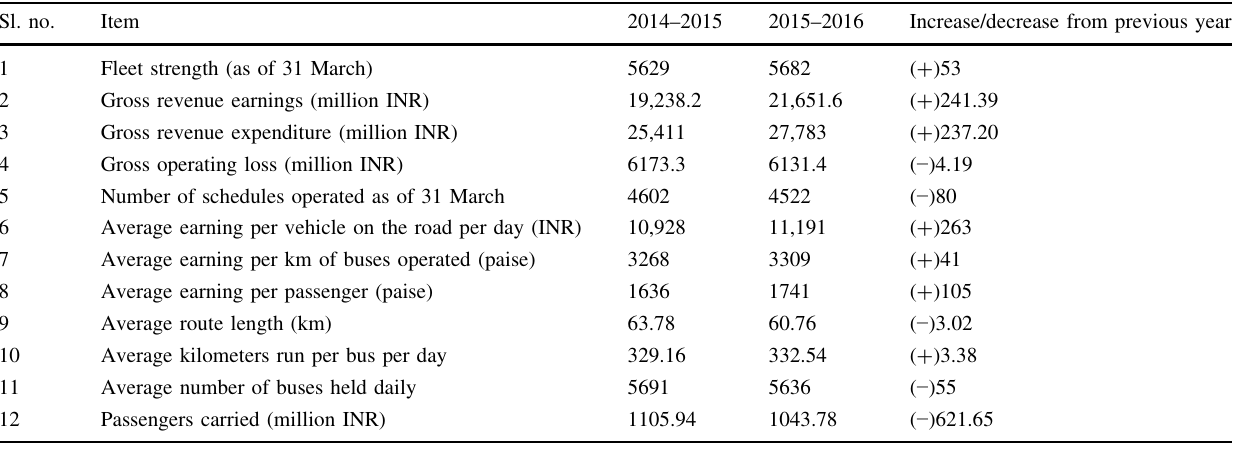
Table 2 Major indicators showing the operational efficiency of the KSRTC [32] Sl. no.